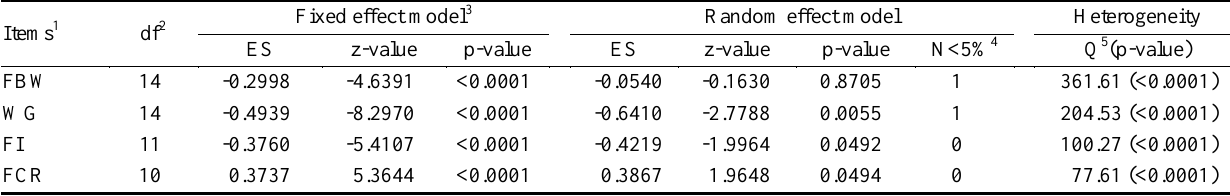
Table 2. Effect of CLA feeding on the growth performance of broiler chicken Items 1 df 2